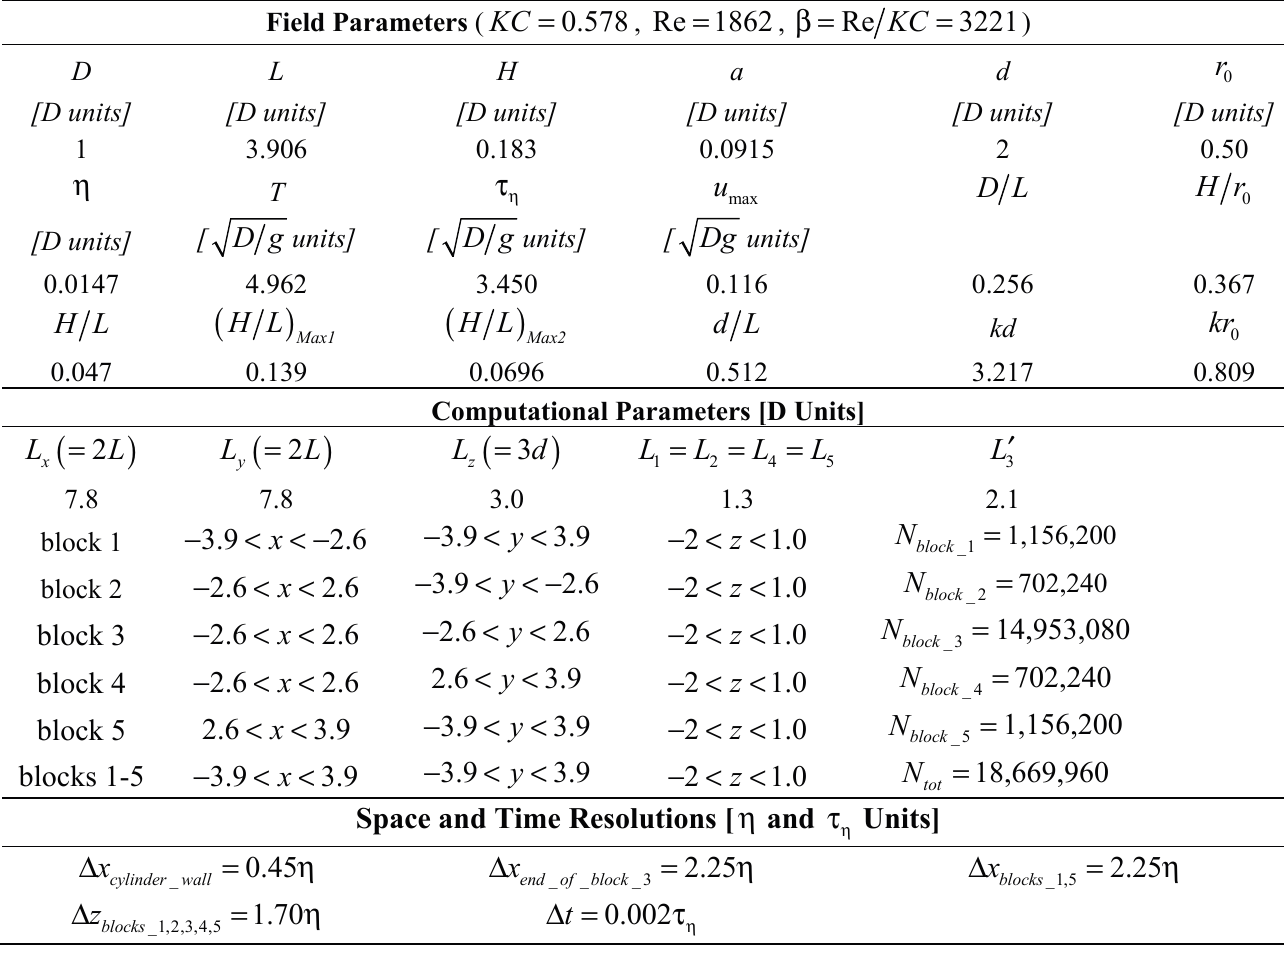
Table 4. Characteristic parameters used for the Navier-Stokes